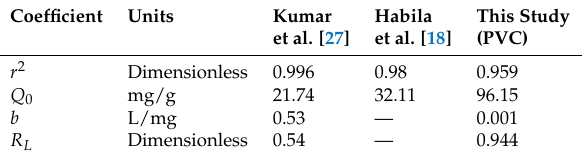
Table 4. Langmuir coefficient comparison with other studies.